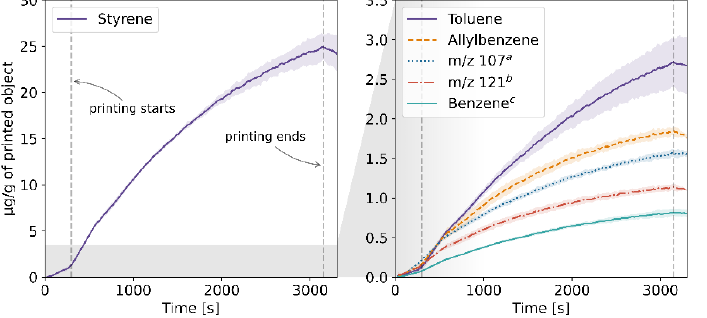
Figure 2. The mixing ratio of main VOCs within the enclosure during FFF 3D printing with the ABS filament. a,b,c see Figure 1 caption.